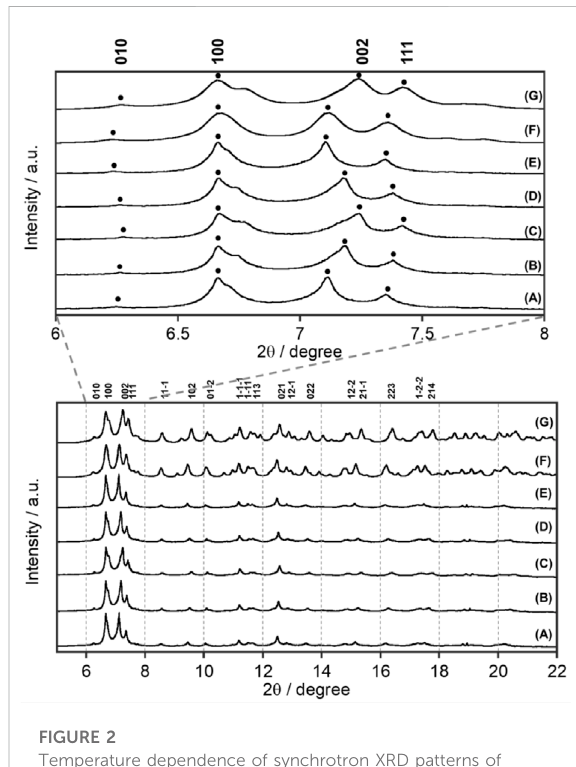
FIGURE 2 Temperature dependence of synchrotron XRD patterns of Eu L at X-ray wavelength λ = 0.998983 Å: (A) 300 K, (B) 200 K, (C) 90 K, (D) 200 K, and (E) 300 K. Simulated pattern from single- crystal X-ray analyses (Figure 1) at (F) 300 K and (G) 100 K.